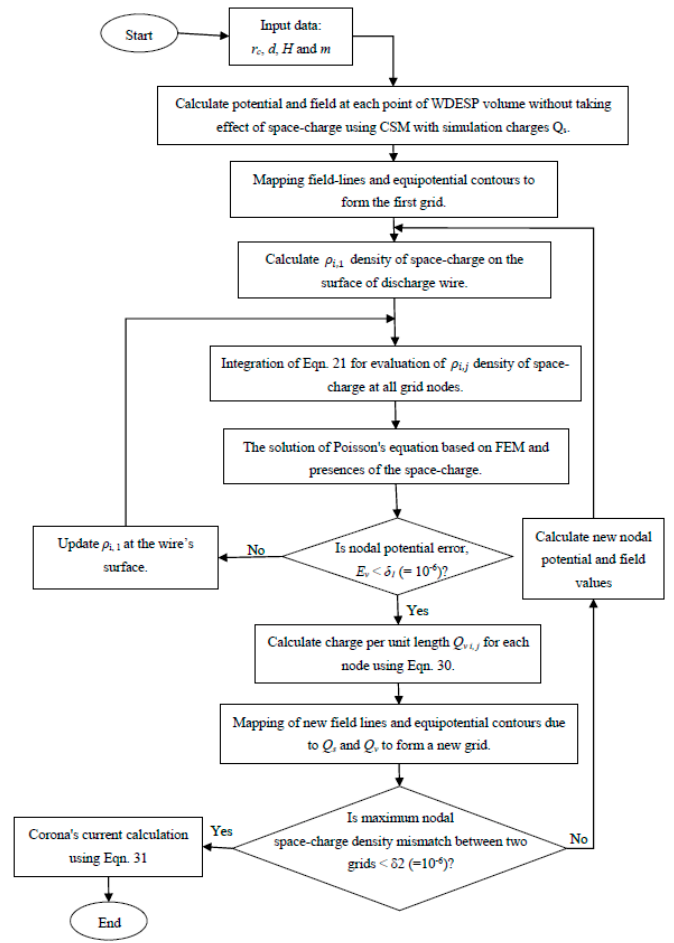
Figure 8. Flowchart for calculating the corona I–V characteristics based on finite element method (FEM).